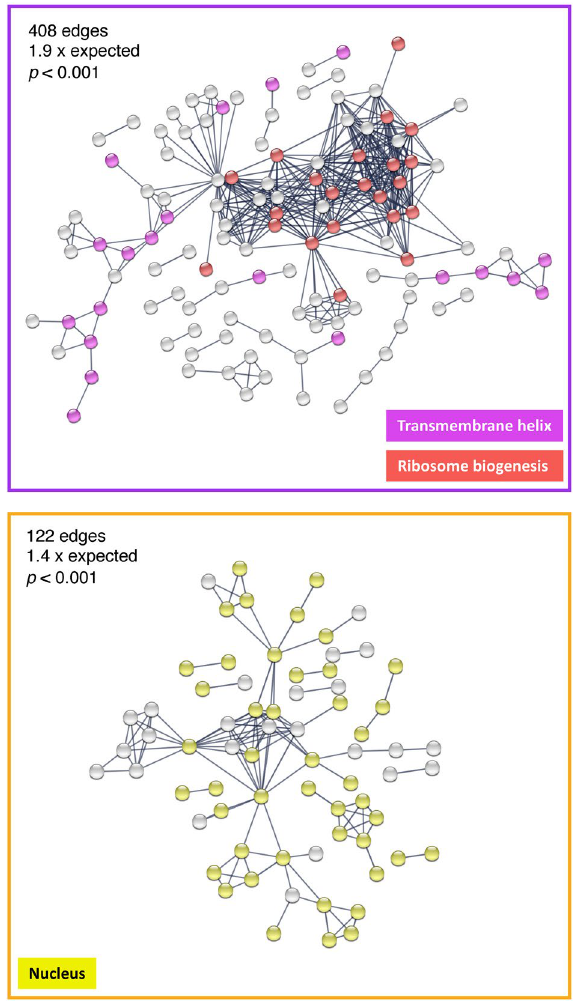
Figure 4. Network enrichment of differentially abundant oocyte proteins. Differentially abundant proteins were analyzed for connectivity and functional enrichment using high confidence protein interactions (confidence > 0.9; line thickness indicates strength of support for protein interactions). Proteins with increased abundance in oocytes from mated (top) and unmated (bottom) females had significantly more interactions than expected. Proteins with greater abundance in oocytes from mated females were significantly enriched for ribosome biogenesis (red) and transmembrane proteins (purple) whereas proteins with greater abundance in oocytes from unmated females were significantly enriched for associations with the nucleus